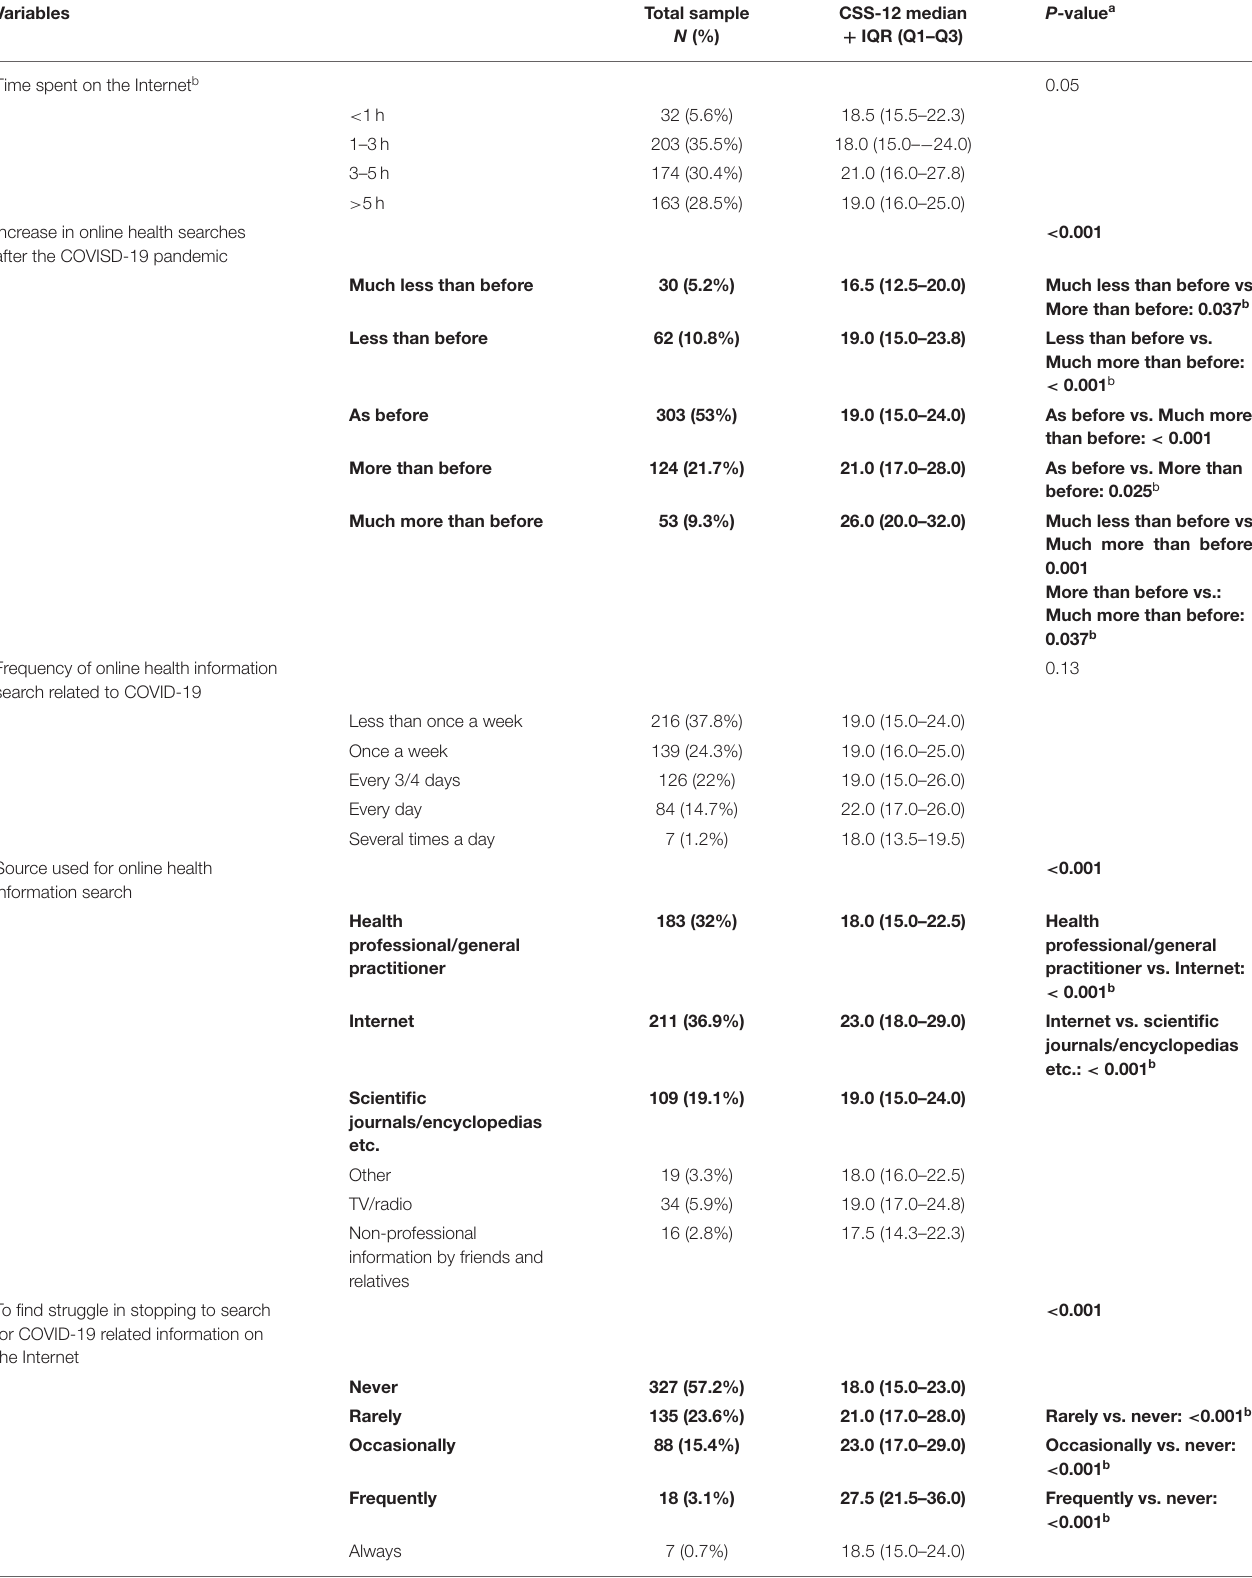
P -value a CSS-12 median + IQR (Q1–Q3) N (%)